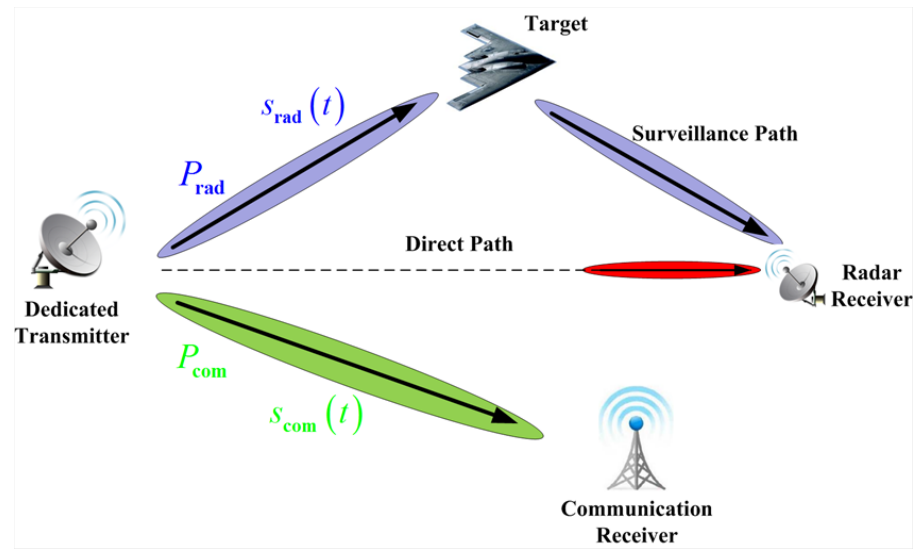
Figure 1. Joint bistatic radar and communication system with a dedicated transmitter, a radar receiver, and a communication